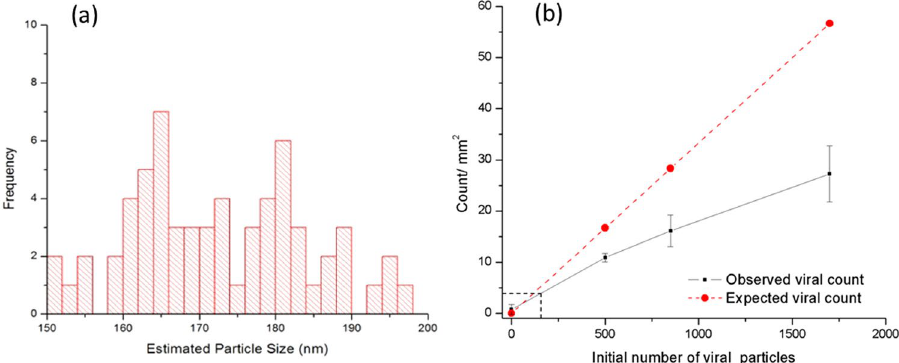
Figure 6. ( a ) Sizing and counting of HSV-1 particles imaged over a FOV of 2.76 mm 2 , with ~1700 viral particles per test, spread over a large FOV of ~30 mm 2 . ( b ) The number of virus particles detected per unit area (mm 2 ) of the substrate as a function of the initial number of viral particles per test/assay. The horizontal dashed line refers to μ + 3 σ of our control samples, i.e., ~4 counts/mm 2 , which corresponds to ~160 viral particles per test, i.e., the intersection of the vertical dashed line with the initial number of viral particles in ( b ). The std. dev. is obtained from a set of N = 3